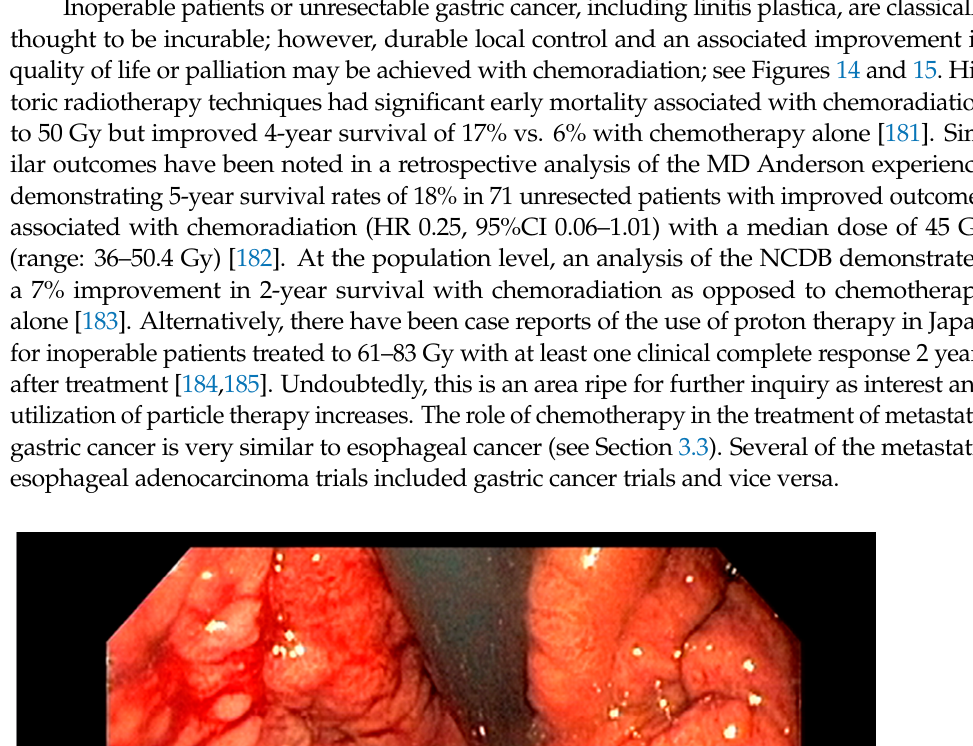
Figure 15. EUS Linitis plastica with significant wall thickening. 4.8.4. Gastric Neuroendocrine Tumors The role of radiation therapy for neuroendocrine tumors is generally limited to pal- liation of symptomatic or oligometastatic disease. To this end, hypofractionated regimens offer patient convenience and the ability to achieve high biological equivalent doses to improve local control [186,187]. There is some limited evidence that SBRT may be an ef- fective option for treatment of functional neuroendocrine tumors, with clinical and bio- chemical responses reported in four patients [188].